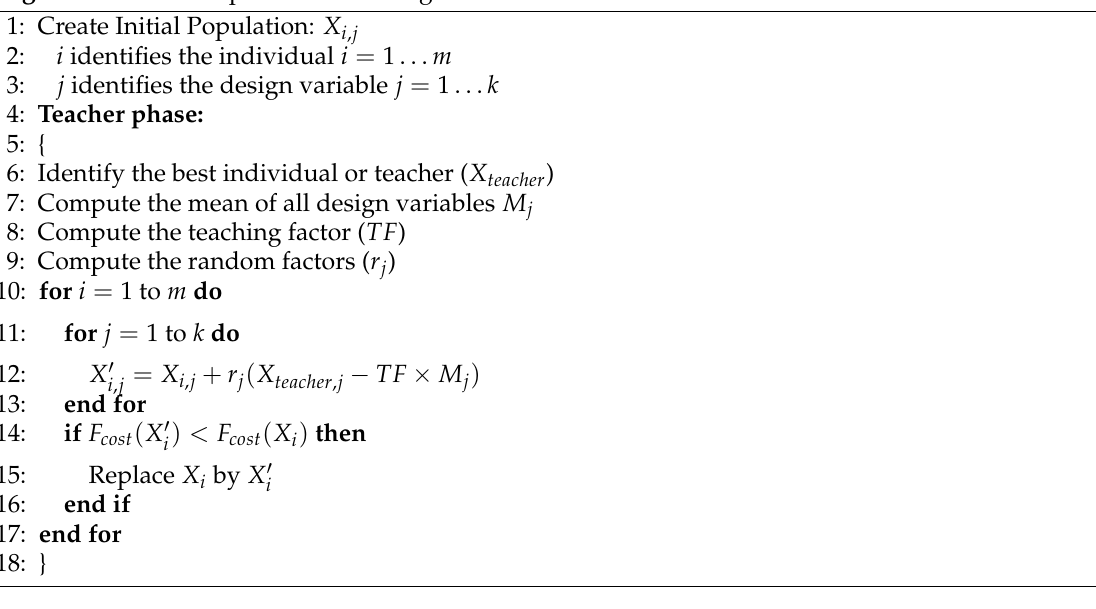
Algorithm 1 Teacher phase of TLBO algorithm.